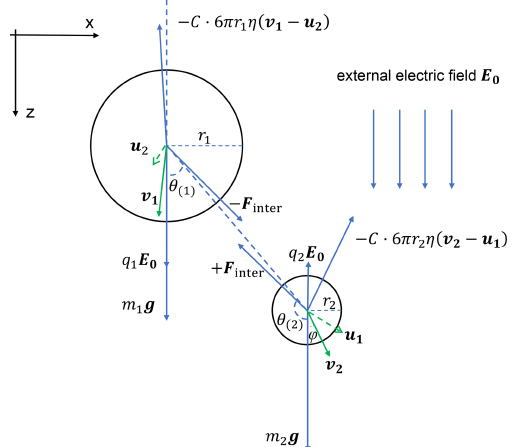
Figure 2. A schematic diagram of all the forces acting on two charged droplets and droplet velocities and the induced flow veloc- ities. The electric field E 0 is vertically downward, and the electric charges are q 1 > 0 ,q 2 < 0. Note that the electrostatic force F e1 , F e2 includes two parts, namely the electric force from the other droplet ( F inter in the figure) and the force purely from the external electric field ( q 1 E 0 , q 2 E 0 in the figure).